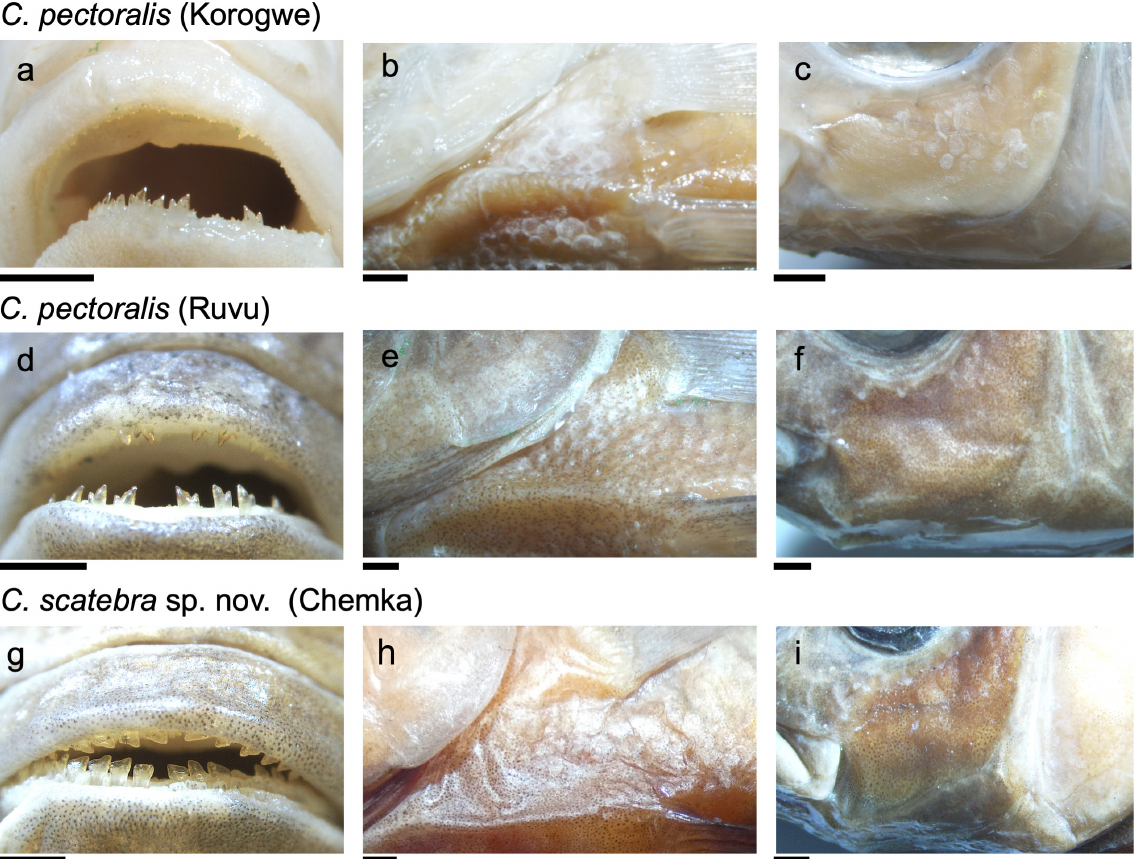
Fig. 7. Morphology of Ctenochromis Pfeffer, 1893. a, d, g . Oral teeth. b, e, h . Chest squamation illustrating scale-free patches. c, f, i . Cheek squamation illustrating the reduction in scale number towards the